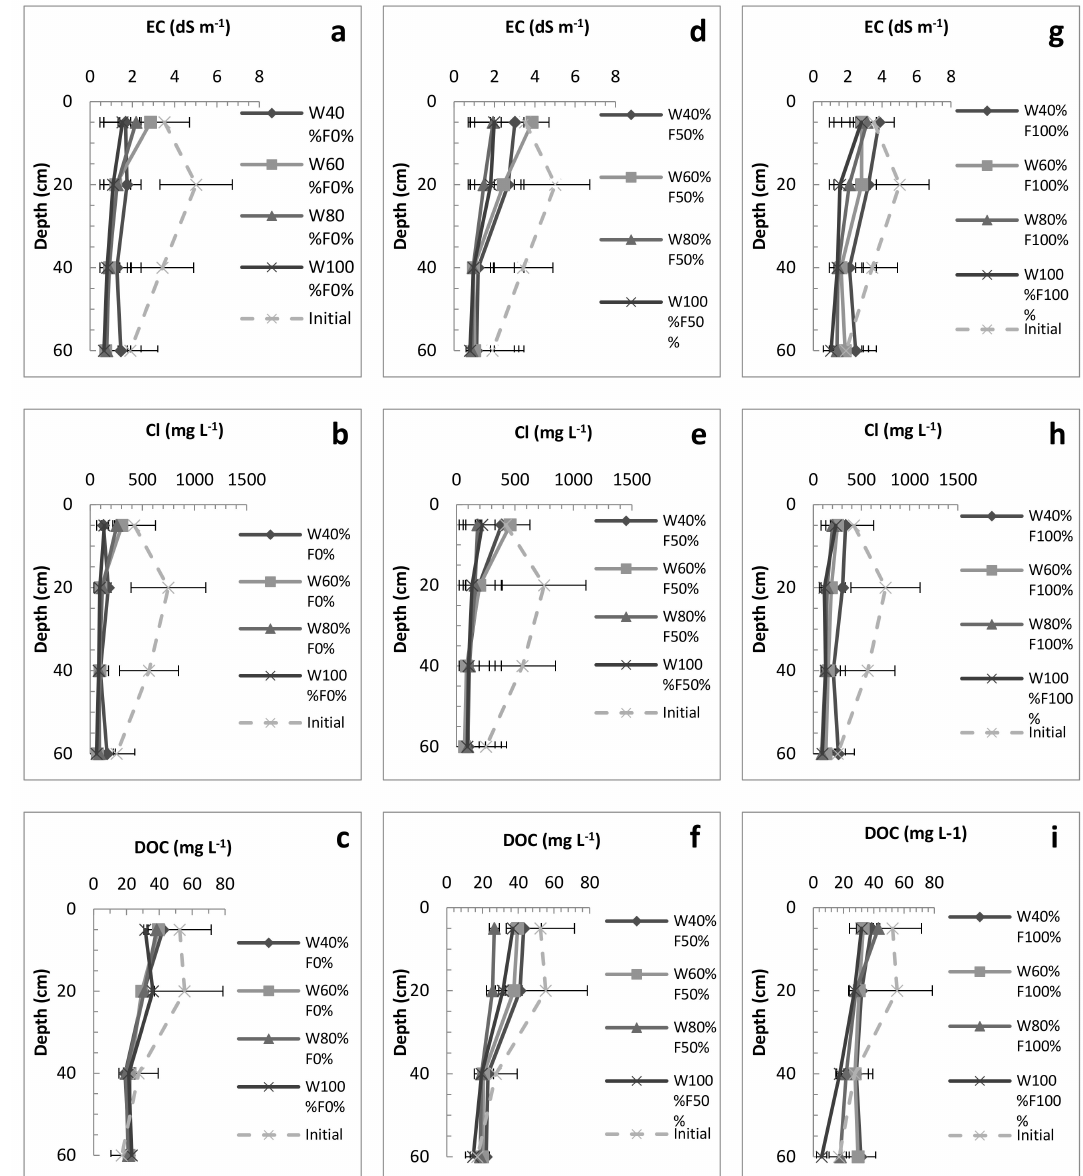
Figure 7. Mean values of soil sample analyses (1:1 soil:water) for EC, Cl − , and DOC at four different depths (5, 20, 40, and 60 cm) according to the irrigation regime. The dashed line (‘Initial’) represents the sampling at the beginning of the season. ( a , b , c ) F0%; ( d , e , f ) F50%; ( g , h , i )